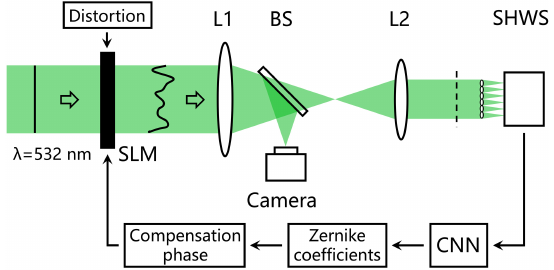
Fig. 1. The schematics of the simulation system setup. L1 – L2, lens; BS, nonpolarizing beam splitter. The black solid line indicates the wavefront of the incident beam and the black dotted line indicates the rear pupil plane of the micro-lens array.